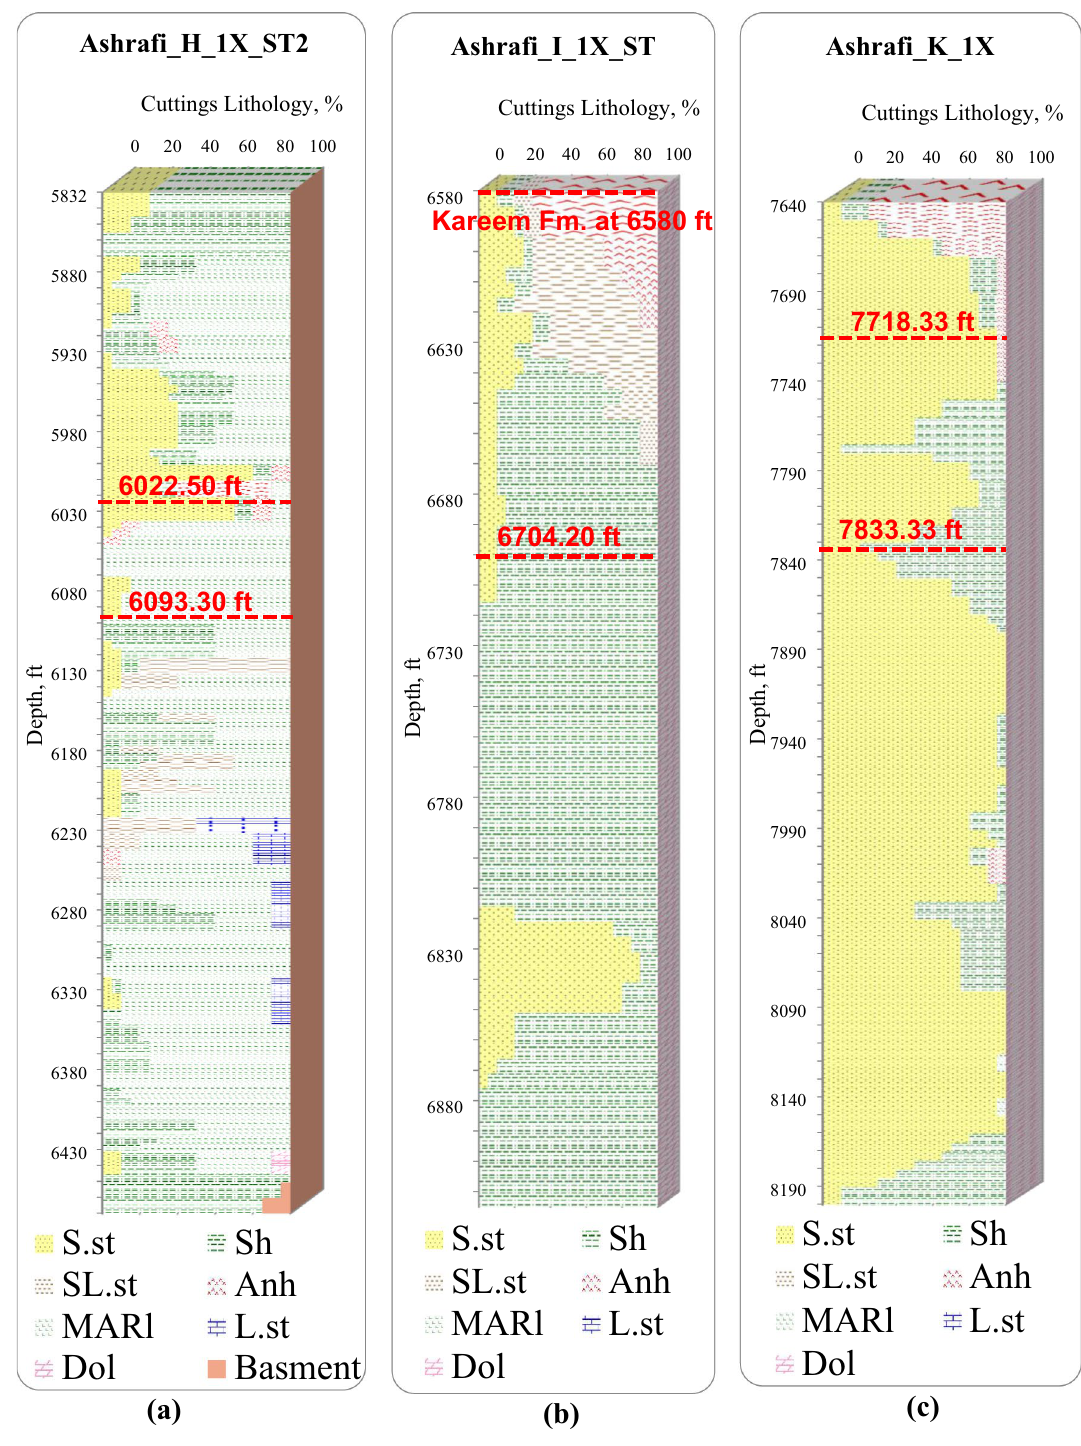
Fig. 3 Lithology percent variation with depth. a Ashrafi_H_1X_ST, b Ashrafi_I_1X_ST, and c Ashrafi_K_1X. The red dashed lines represent the possible average overpressure